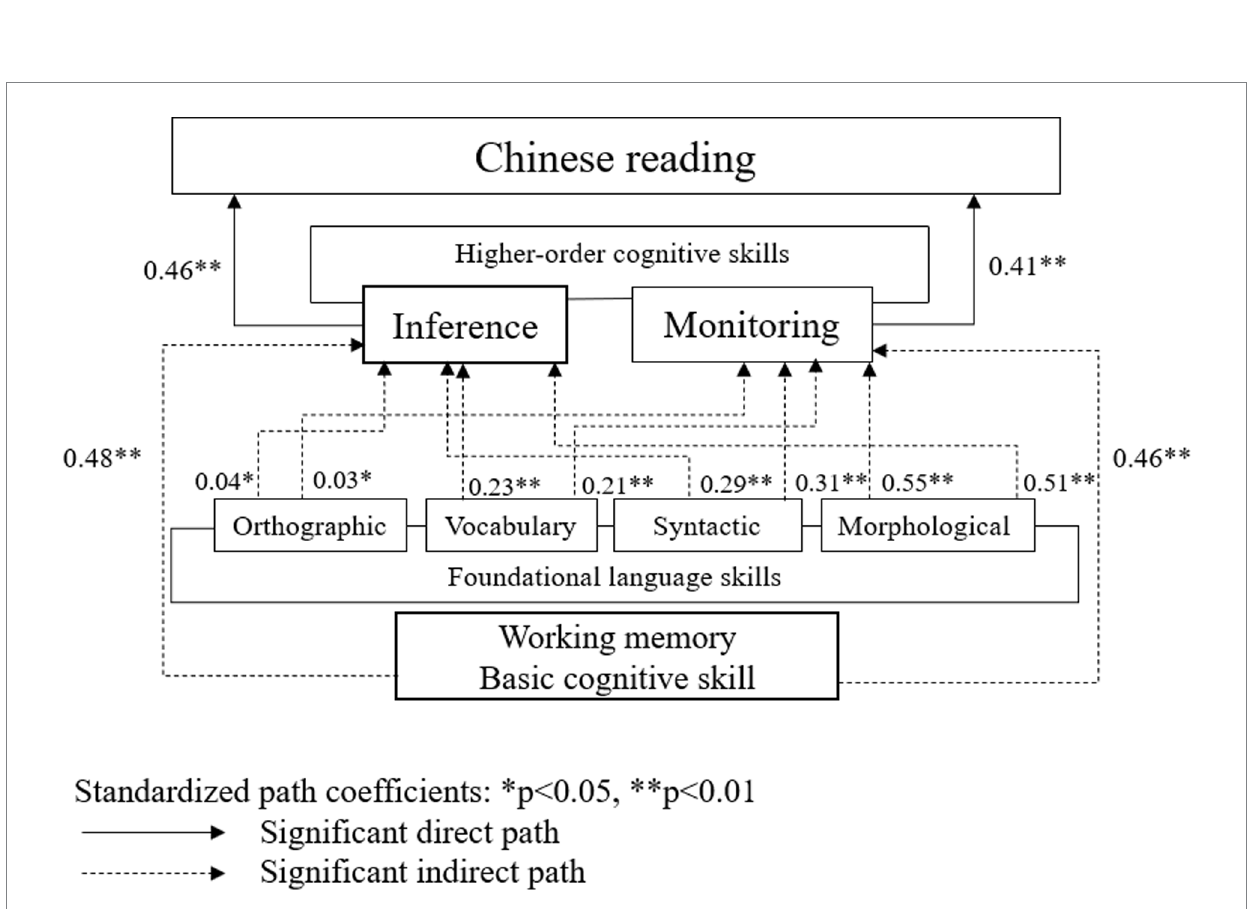
FIGURE 1 Standardized structural regression weights for the direct and indirect effects of the predictors in the L2 Chinese reading